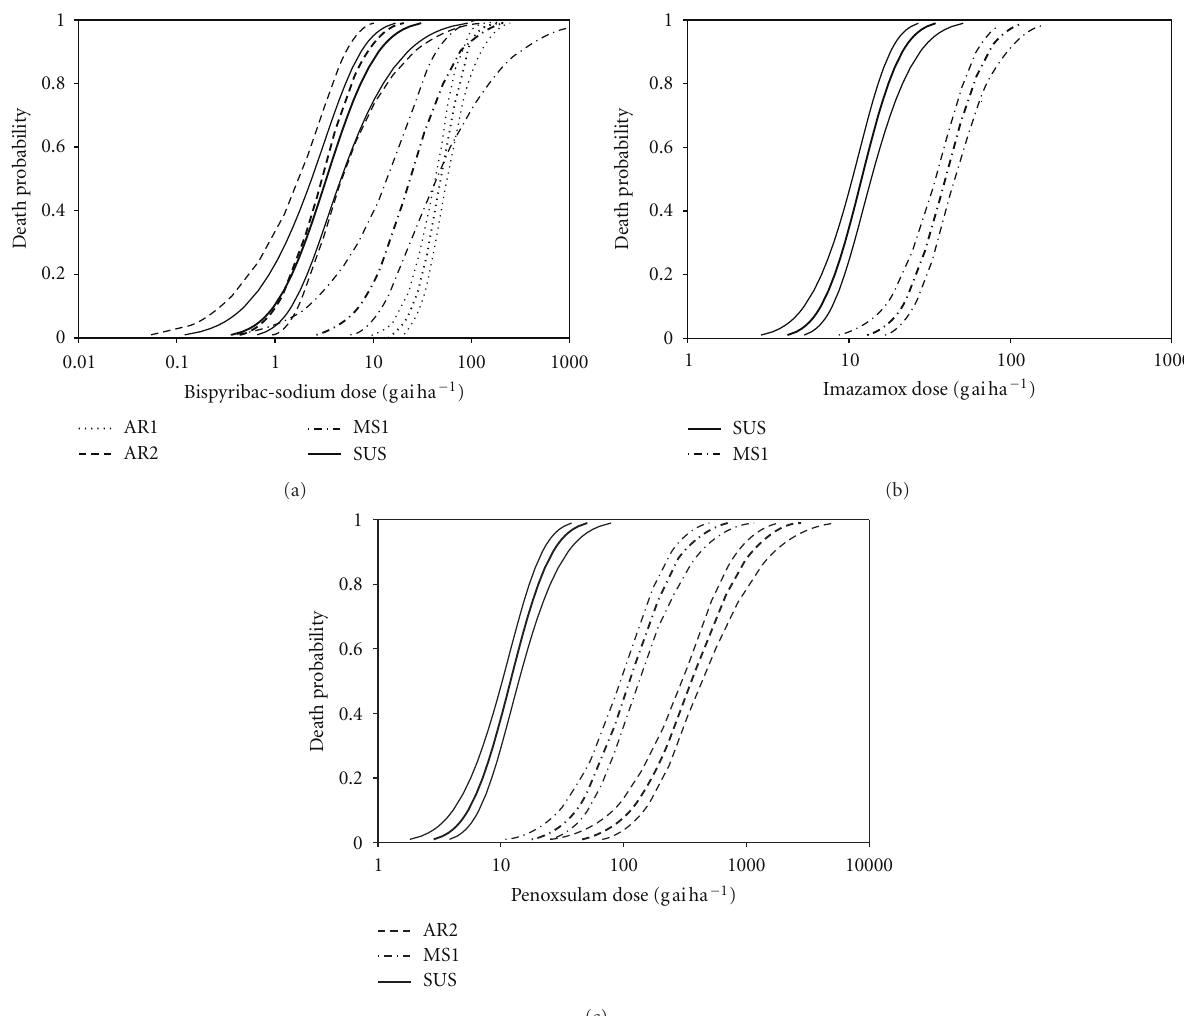
Figure 1: Probit analysis to predict the lethal dose of (a) bispyribac-sodium, (b) imazamox, and (c) penoxsulam required to kill 50% (LD 50 ) and 90% (LD 90 ) of E. crus-galli plants of each population (thick lines). Thin lines represent 95% confidence intervals (CIs) for each population. Lines of AR1 and AR2 for imazamox, and of AR1 for penoxsulam not shown, because the highest tested doses of imazamox (32X; 1X = 35 gai ha − 1 ) and penoxsulam (32X; 1X = 35 gai ha − 1 ) were not able to kill 50% of plants of these populations.